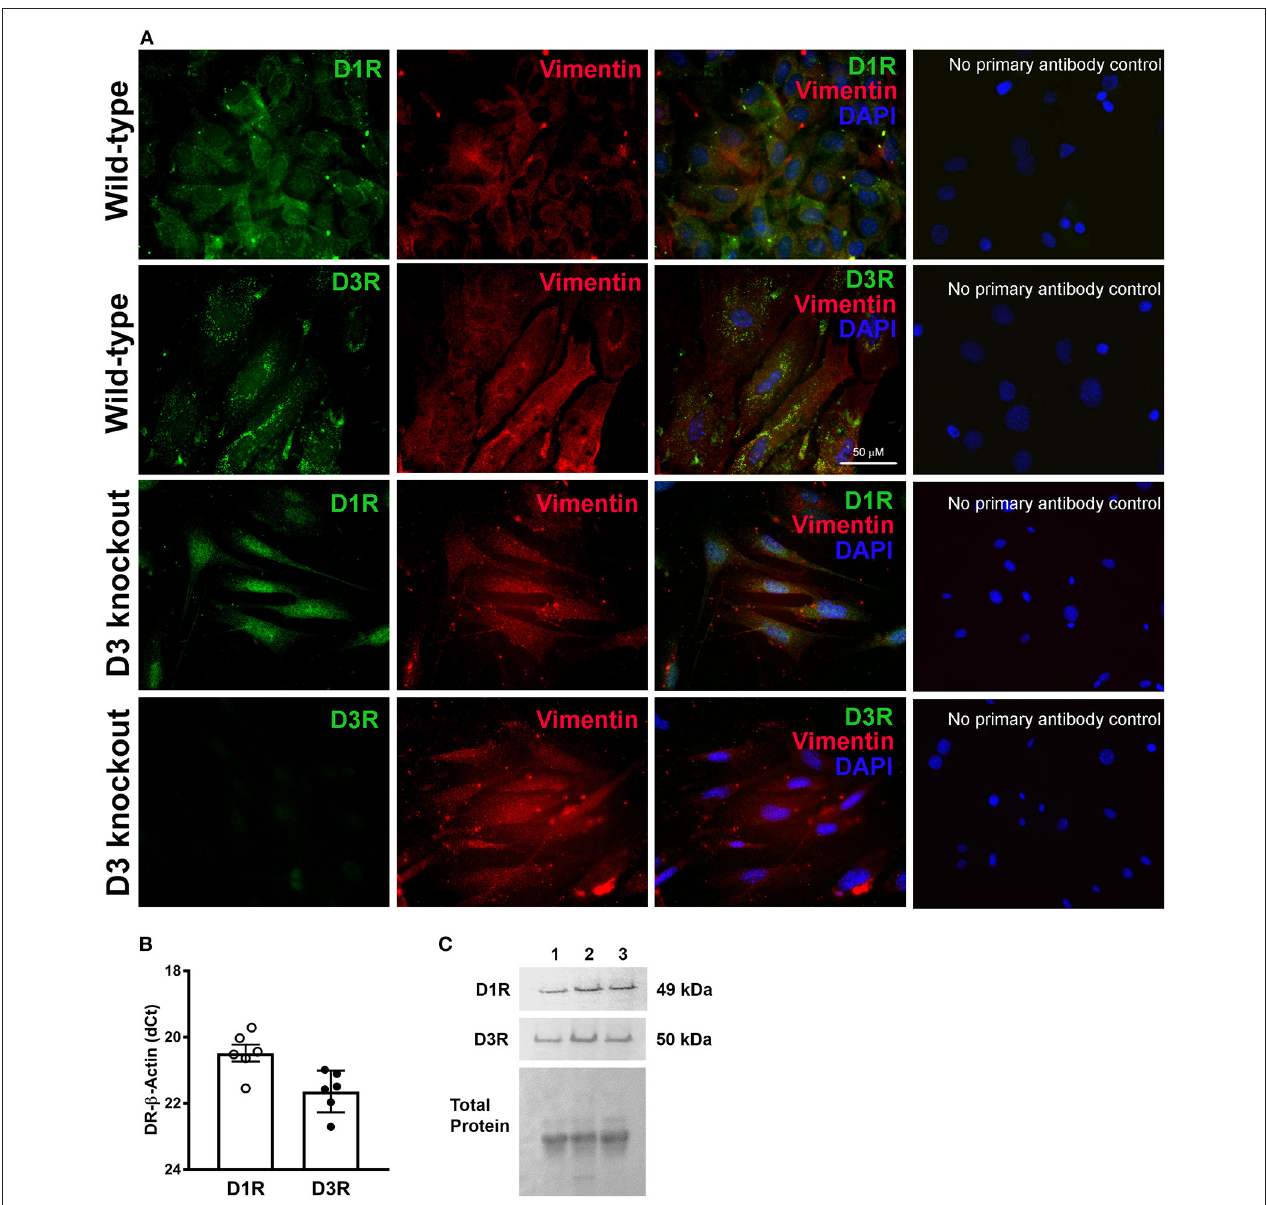
FIGURE 2 | The expression and distribution of dopamine receptors, D1R and D3R in mouse primary cardiac fibroblasts: (A) Representative photomicrographs showing immunofluorescence staining of D1R and D3R which co-localized with cardiac fibroblasts specific marker vimentin staining in the isolated WT and D3KO primary cardiac fibroblasts in culture. Cardiac fibroblast expression of D1R and D3R is not lost when primary cells are maintained in cell culture. As expected, there is no observable staining for D3R in D3KO cardiac fibroblasts. No primary antibody control images show the specificity of the primary antibodies used. (B) Gene expression determined using TaqMan primers by real-time qPCR. The normalized -dCT values indicate that there is relatively higher expression D1R compared to D3R in cardiac fibroblasts. (C) Receptor protein expression determined by western blot using receptor specific antibodies as described in methods section.